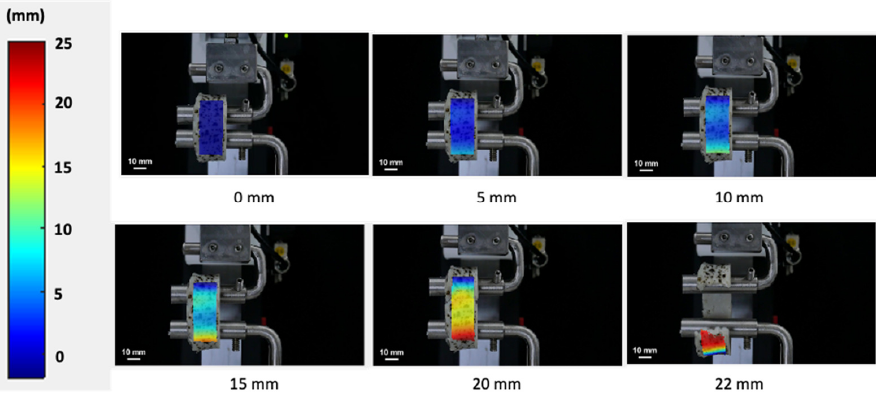
Figure 5. Contour plots of surimi gel displacement during the ring tensile test to the failure point.